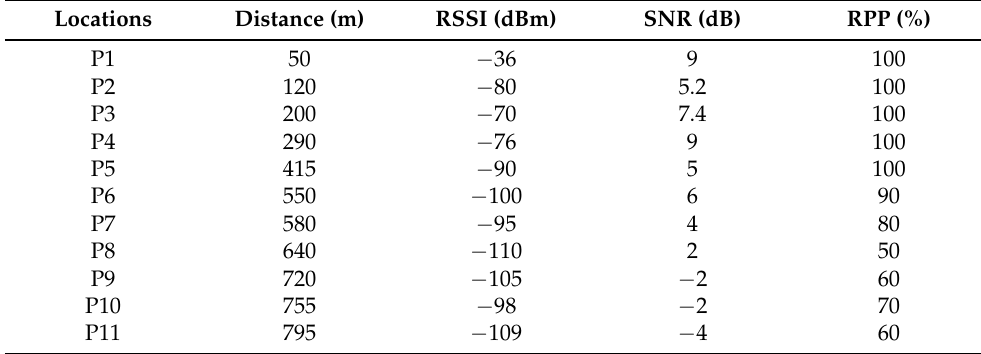
Table 3. SNR, RSSI and RPP of received packets from each measurement point.